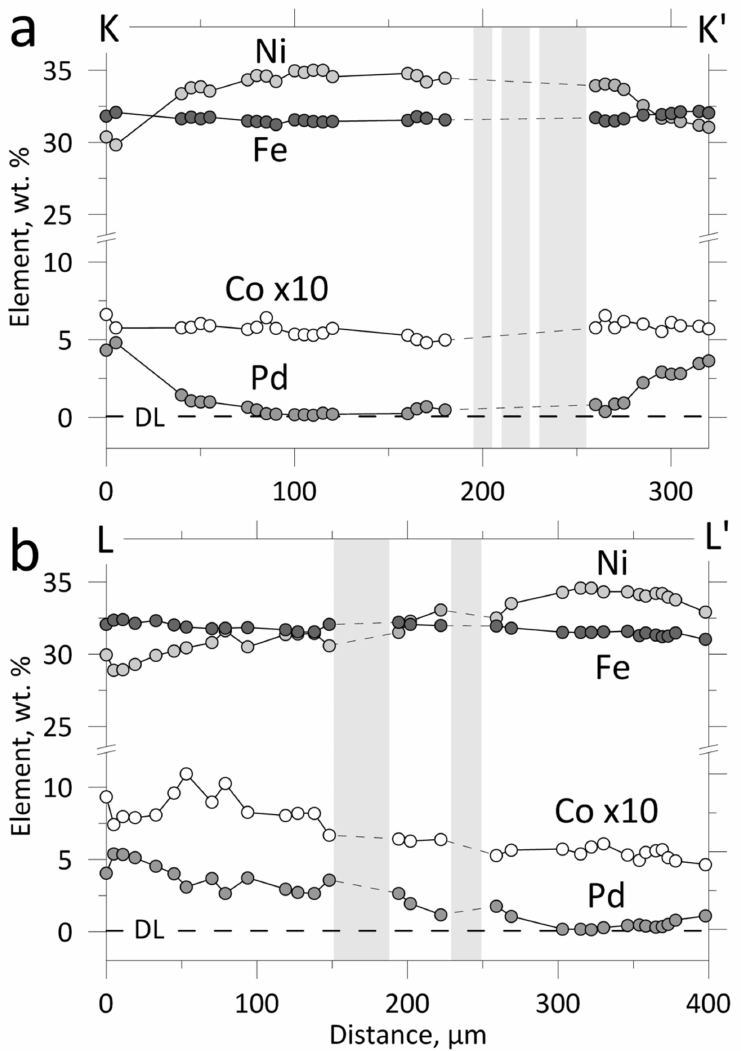
Figure 9. Microprobe profiles through the large crystal of Pd-rich pentlandite from the cubanite ore (sample 32 − 11, depth 76.5 m): ( a ) Microprobe profile KK’; ( b ) Microprobe profile LL’. The gray areas show discontinuities in the pentlandite crystal due to the replacement of pentlandite by cubanite. The dashed line marked DL shows the detection limit of Pd in pentlandite, corresponding to 0.06 wt.%. The position of the profiles is shown in Figure